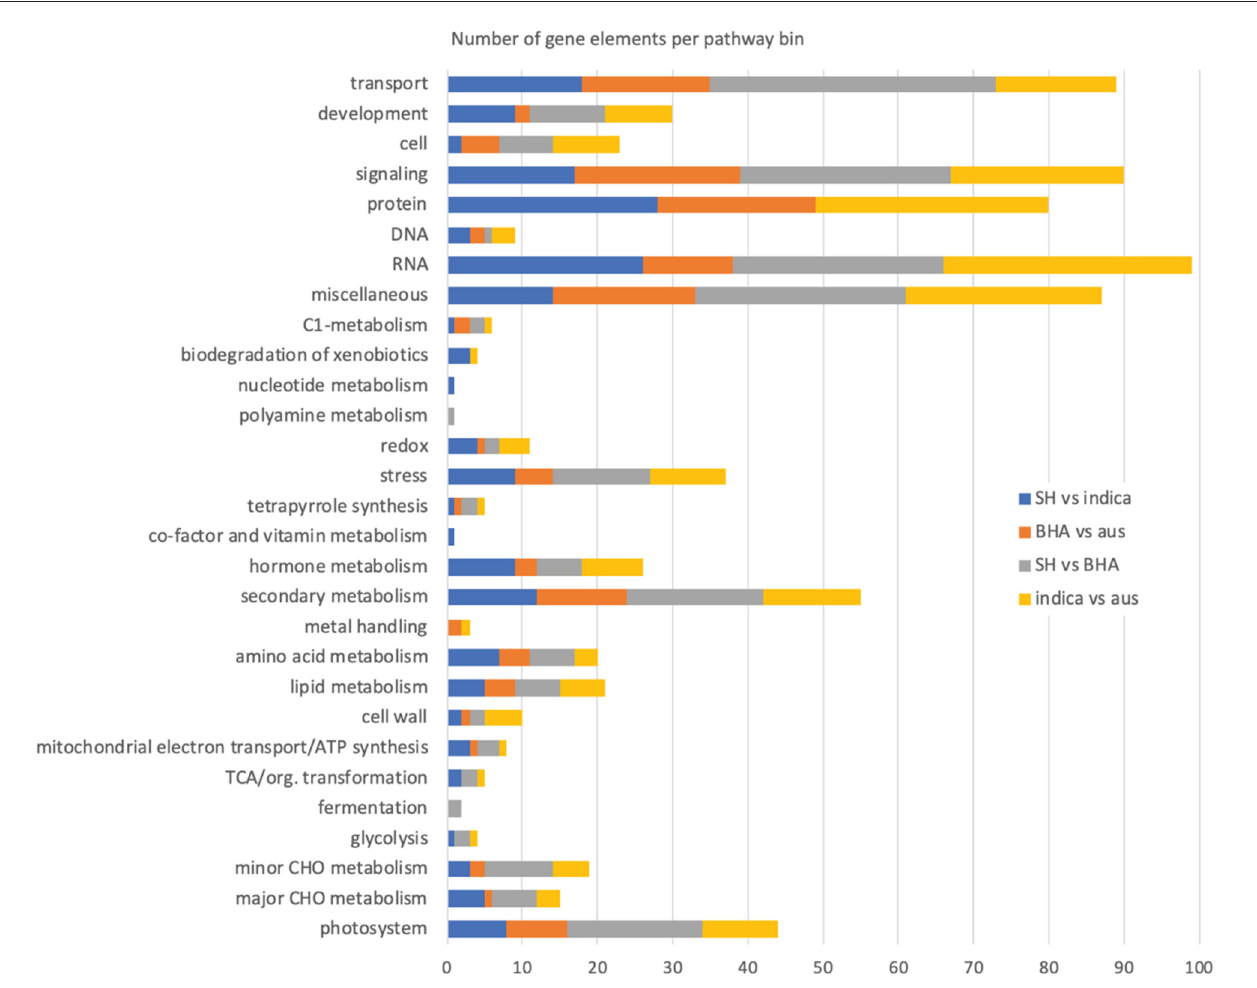
FIGURE 3 | Number of genes mapping to higher order MapMan plant pathway bins in the various weed-crop, crop-crop, and weed-weed comparisons. The “not assigned” pathway category, in all cases the largest category of mapped genes, is not included in the plot.